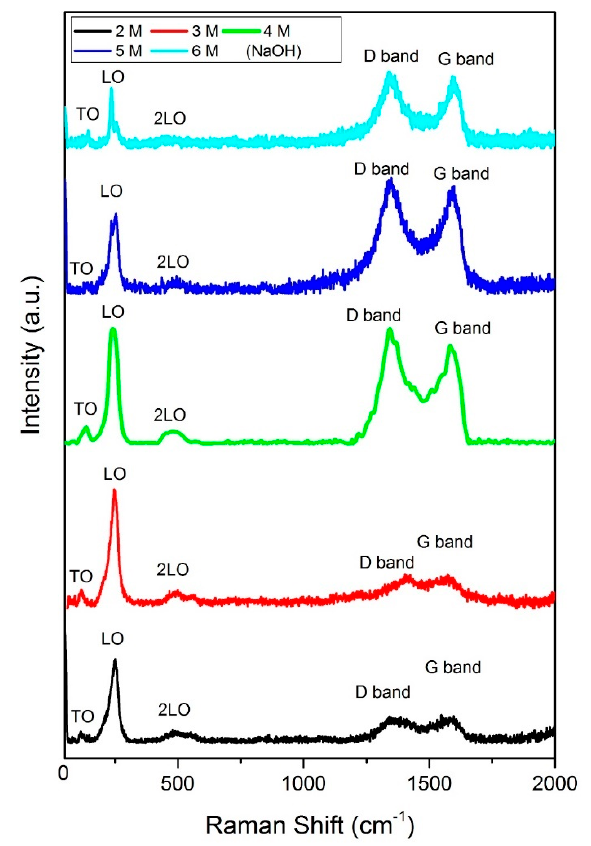
Figure 2. Raman spectra of ZnSe/GO composite synthesized with different NaOH concentrations.